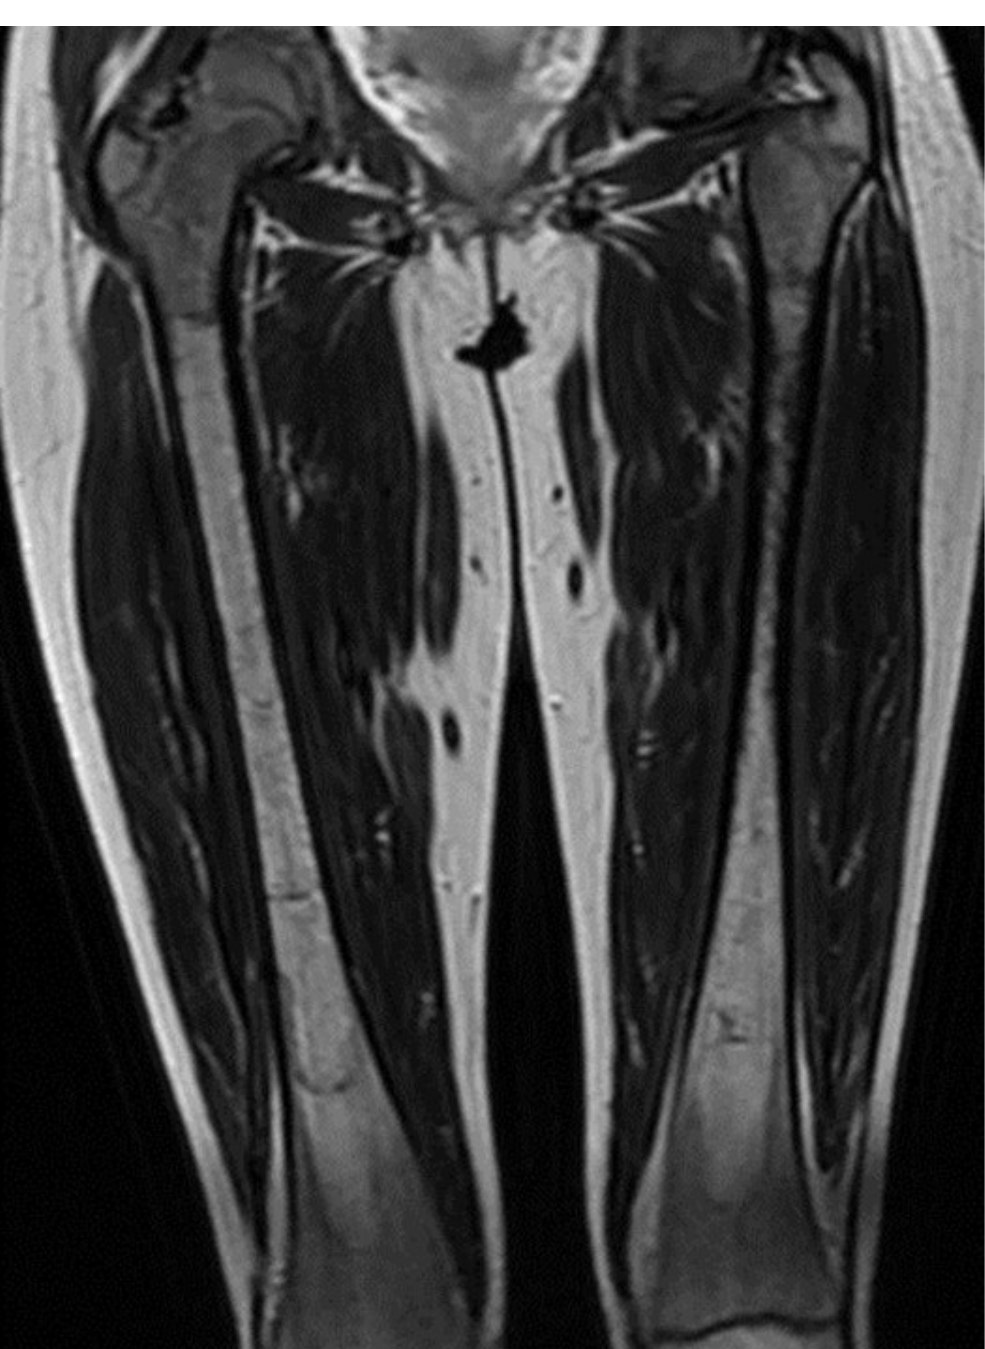
Figure 4. Femur with changes along the bone, Coronal T2-weighted FSE Image.